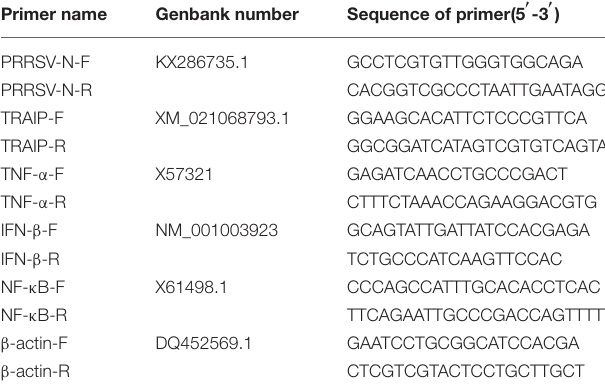
TABLE 2 | Primers used for qRT-PCR